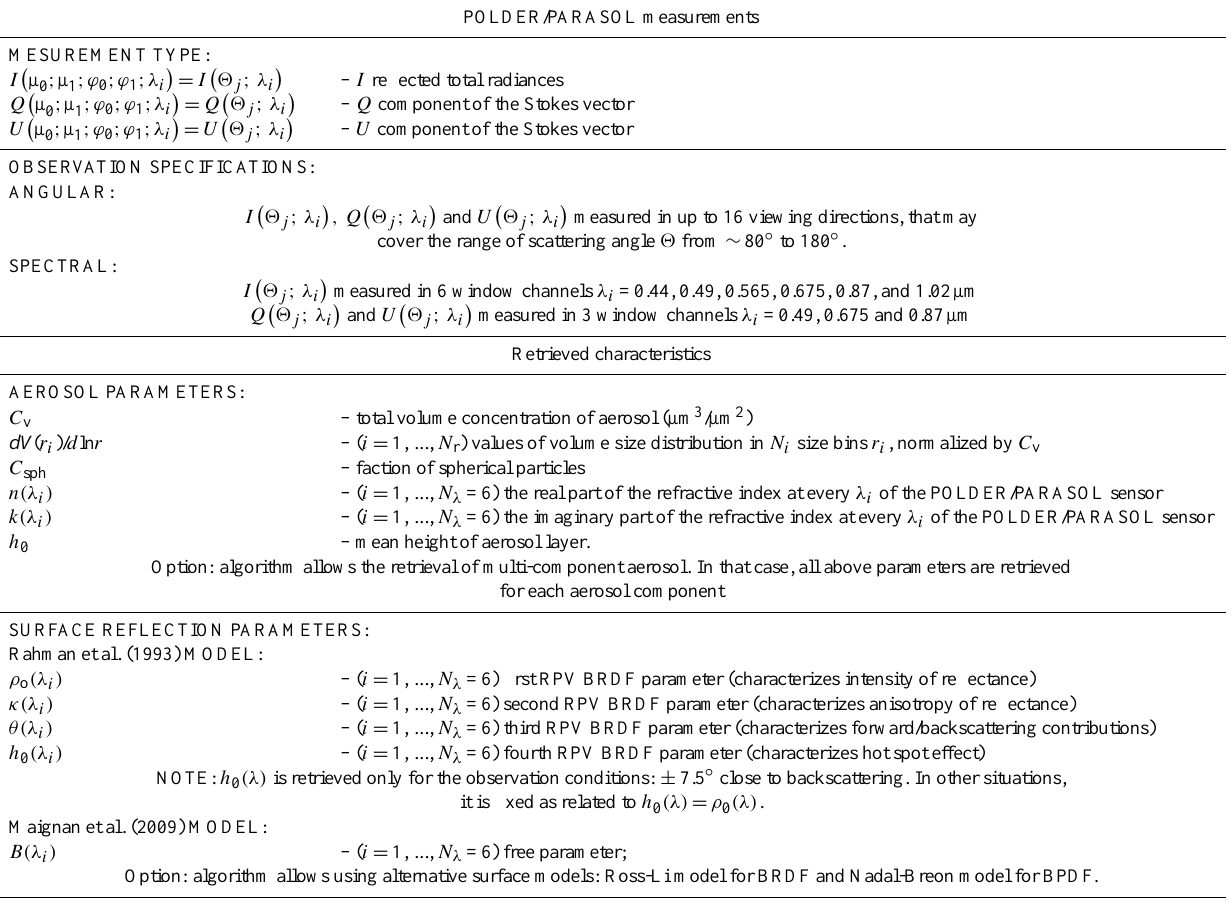
Table 1. List of measured and retrieved characteristics considered in POLDER/PARASOL algorithm. POLDER/PARASOL